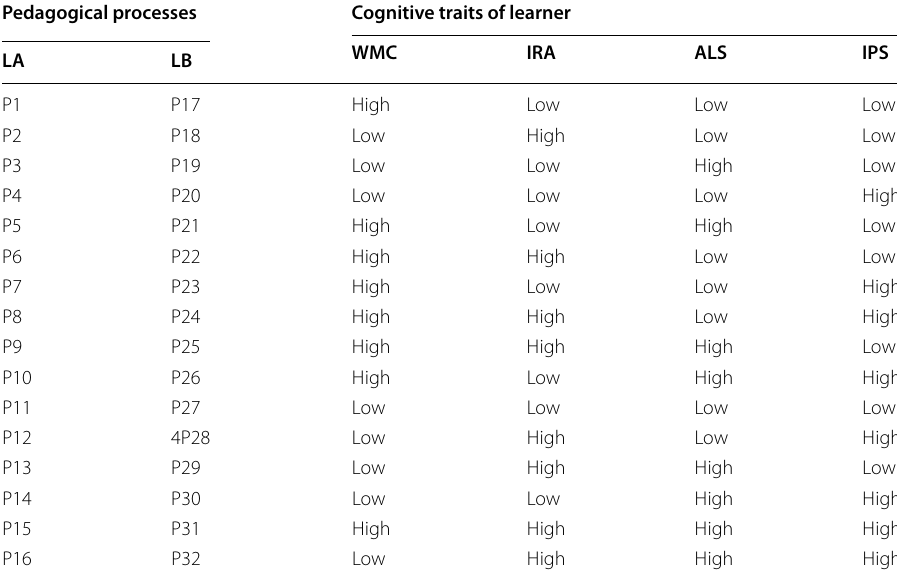
Table 1 Selection criteria of pedagogical processes Pedagogical processes Cognitive traits of